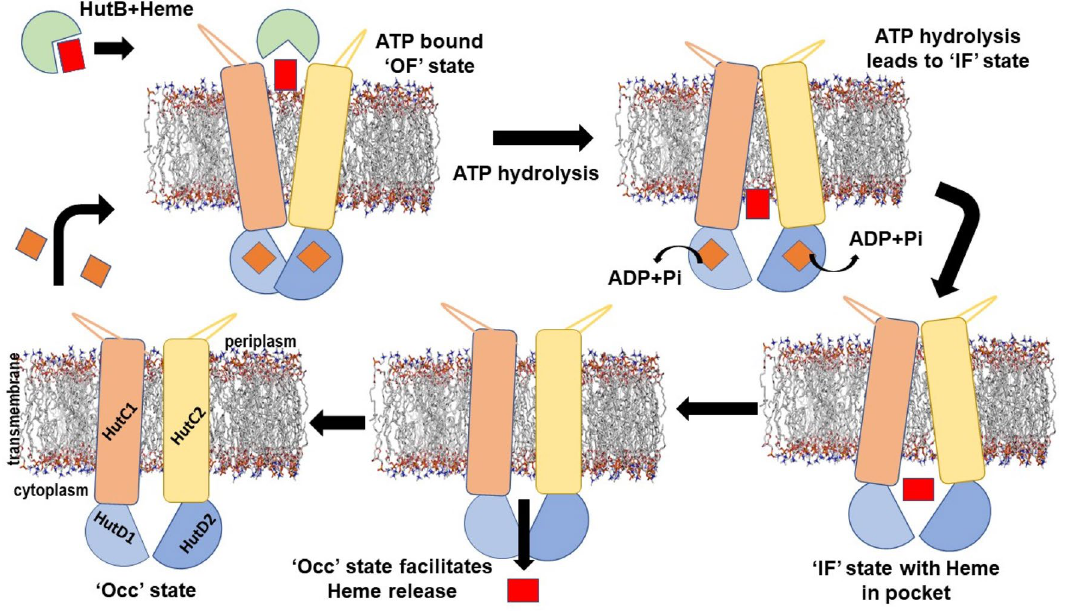
Figure 9. Proposed reaction mechanism. Involvement of TM4–TM5 loop in ATP hydrolysis causes cytoplasmic gate opening (IF state) easing heme release to the inter-dimeric pocket. Heme release to cytoplasm takes place in the absence of ATP. Formation of occluded state constricts the pocket and releases